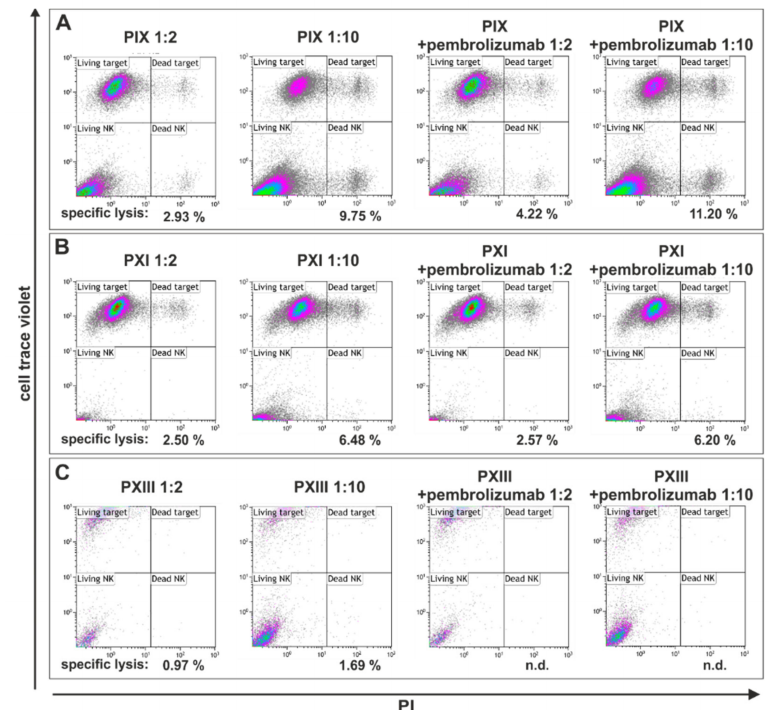
Figure 5. Flow cytometry of natural killer cell-treated prostate cancer stem cell populations showed no effect on cellular survival even with the addition of pembrolizumab. ( A ) The analysis of the natural killer (NK) cell-treated prostate cancer stem cell (PCSC) population PIX showed a killing efficacy of only about 11%, also with pembrolizumab co-culturing (1 target: 10 NK cells; right panels). Without pembrolizumab, the killing rates differed from 2.9% (1 target: 2 NK cells) to 9.8% (1 target: 10 NK cells; left panels). ( B ) The NK cell-mediated lysis of PXI PCSCs showed killing efficacies in a similar range to PIX PCSCs. Flow cytometry revealed a target lysis of 2.5% (1 target: 2 NK cells) to 6.5% (1 target: 10 NK cells) and a maximum killing efficacy of 6.2% with the addition of pembrolizumab. ( C ) PCSCs from PXIII suffered the lowest cytotoxic effects from the NK cell co-culture, while treatment alone led to a maximum specific lysis of 1.7%. The combination with pembrolizumab revealed no detectable NK cell